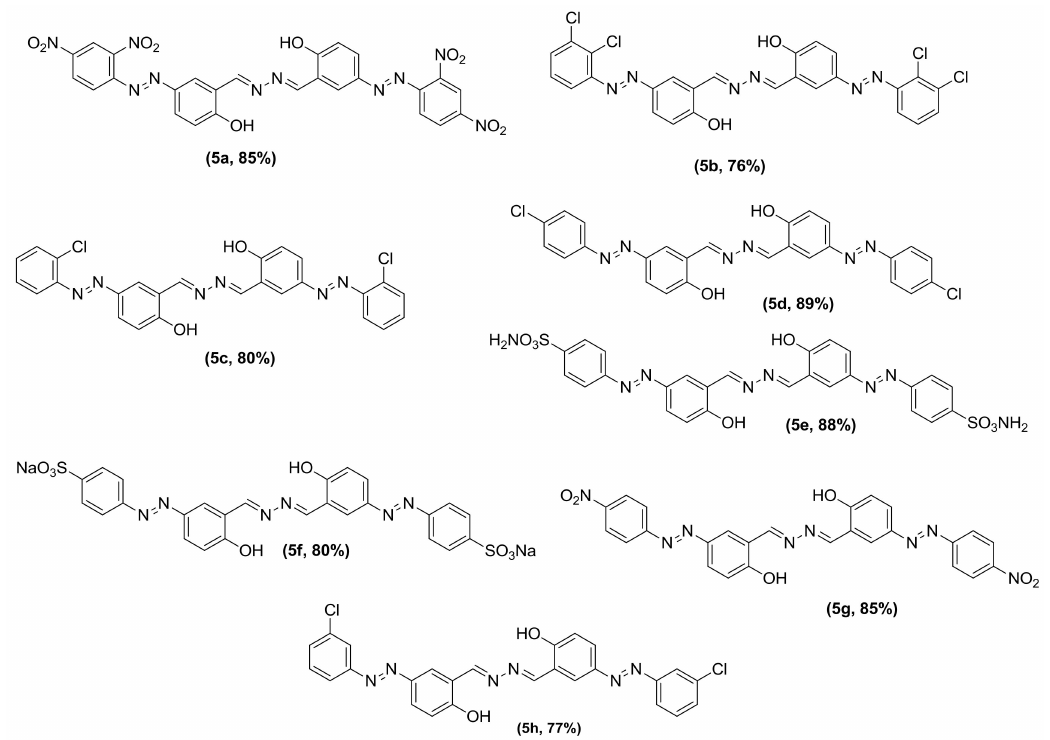
Scheme 2. Structures and yields of synthesized symmetrical molecules ( 5a – h